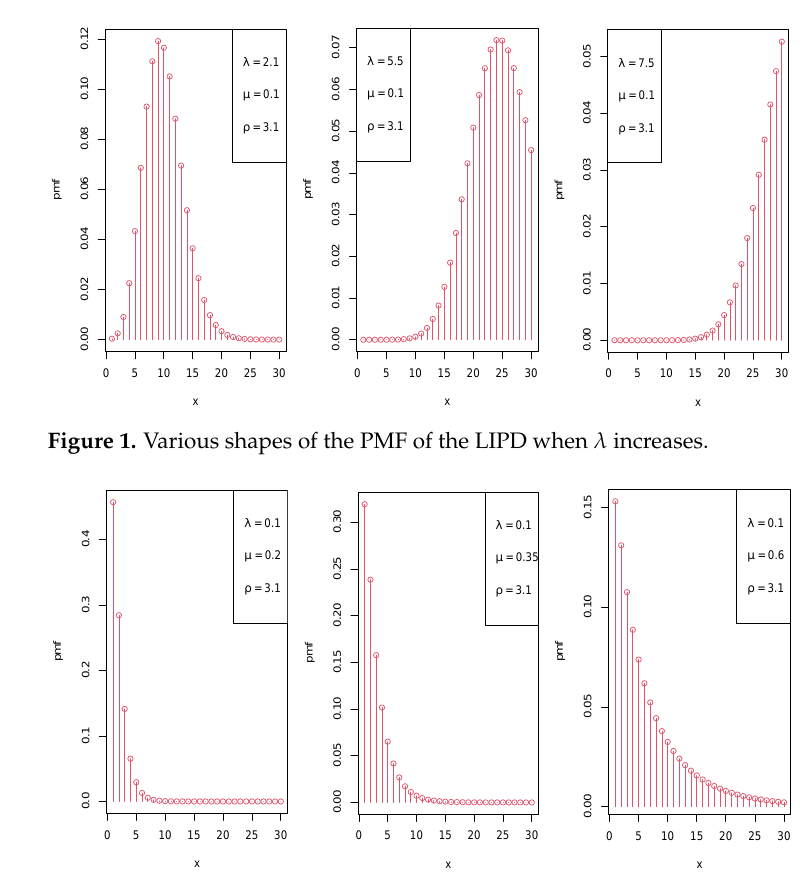
Figure 2. Various shapes of the PMF of the LIPD when µ